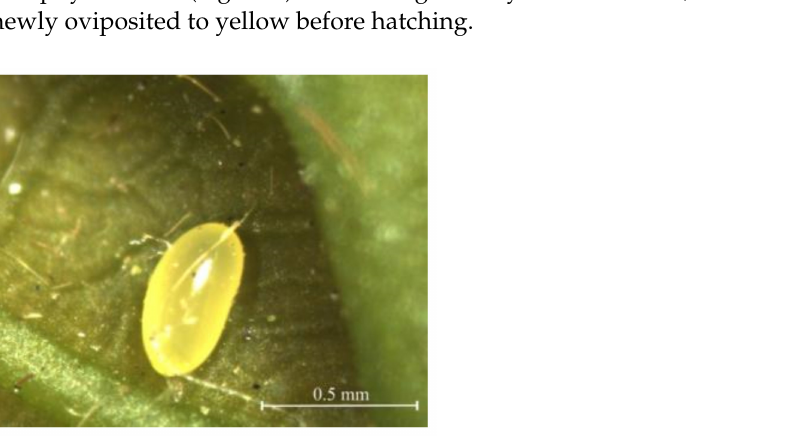
Figure 1. The egg of Rhynchaenus maculosus . Shape: oval; coloration: smooth and bright yellow; development stage: